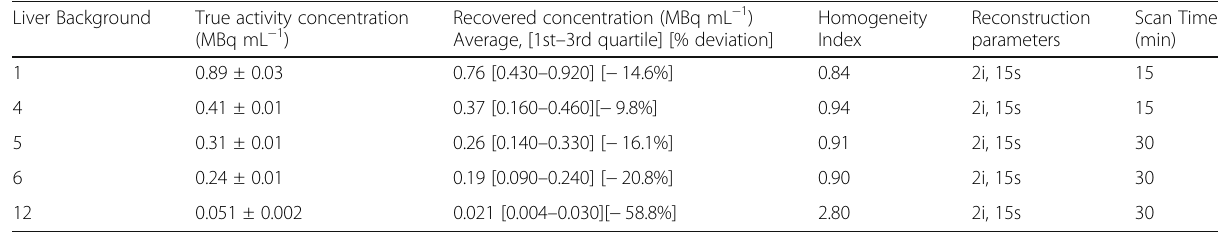
Table 3 Recovered activity in the liver background. Recovered activity concentrations are compared to measured values Liver